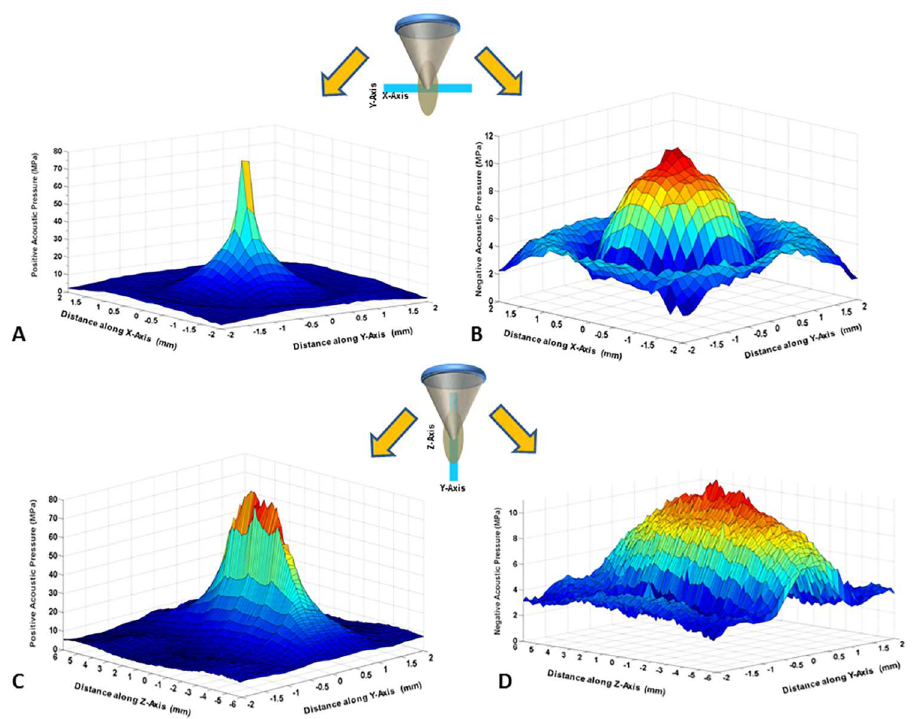
Fig 2. HIFU positive and negative pressure waveforms displayed in 3D at 500 W (free-field), across (A & B) and along (C & D) the plane of the HIFU beam propagation. At this acousticpower, the peak positive pressurewas 65.97 ± 4.42and peak negativepressure of 10.98 ± 0.45. Additionally,the beam width along the HIFU beam propagation is greater than the across the HIFU beam-axis.